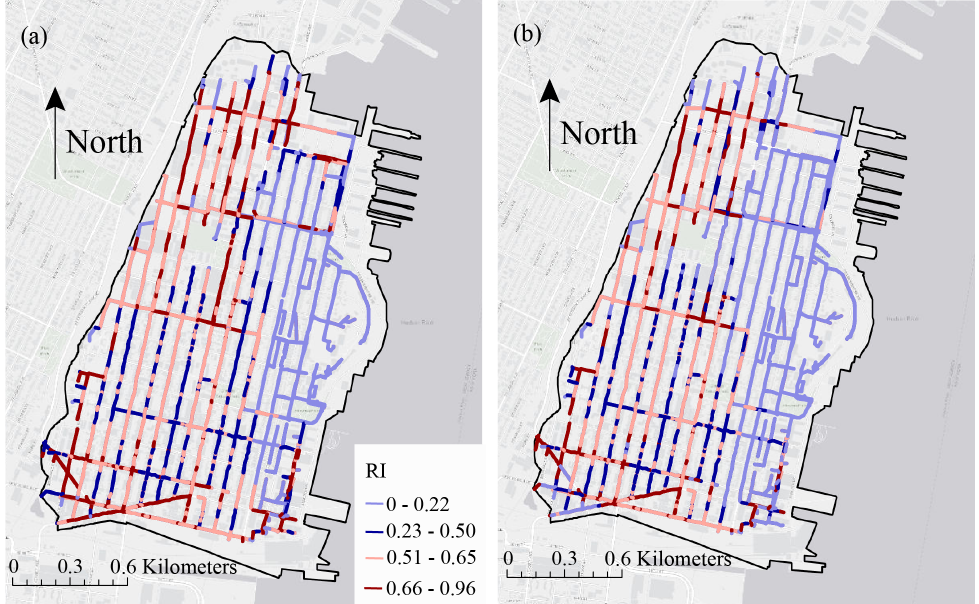
Figure 13. Map of the risk of groundwater infiltration ( RI ) considering: ( a ) the shallowest water table; and ( b ) the deepest water